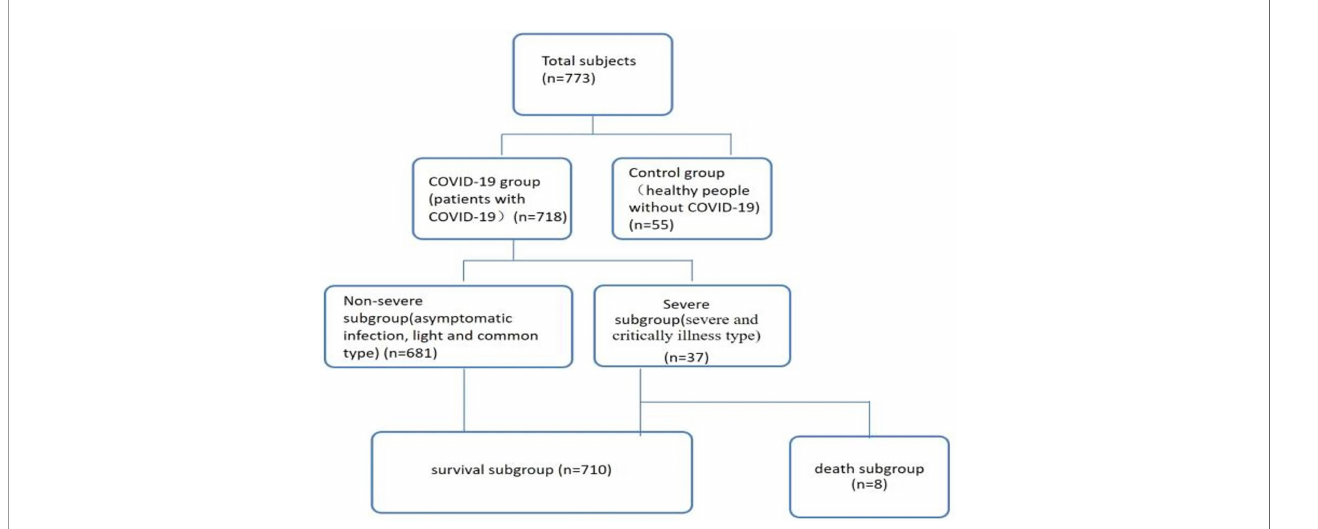
FIGURE 1 | Patient data ( n =773). Non-severe refers to the clinical type of COVID-19 that is asymptomatic, light and common. Severe refers to the clinical type of COVID-19 that is associated with severe and critical